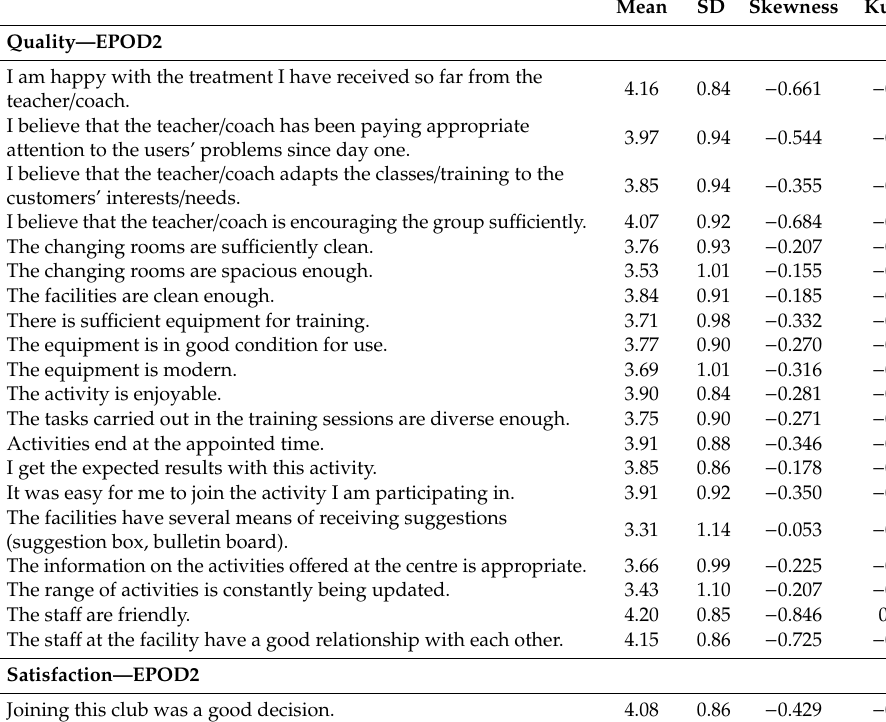
Table 1. Descriptive statistics of the